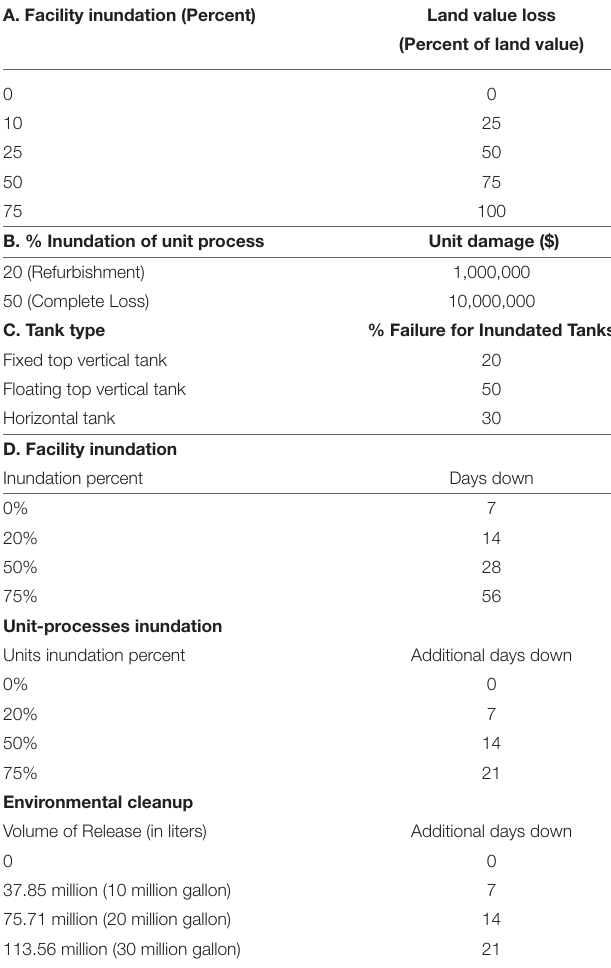
TABLE 1 | (A) Land value loss as a function of facility inundation, (B) Loss algorithm for unit process inundation, (C) Storage tank types and their modeled failure under surge and (D) Modeled relationship between non-operational days and percent inundation of